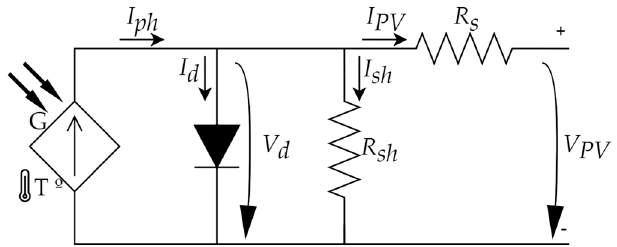
Figure 1. Equivalent electrical model of PV cell.